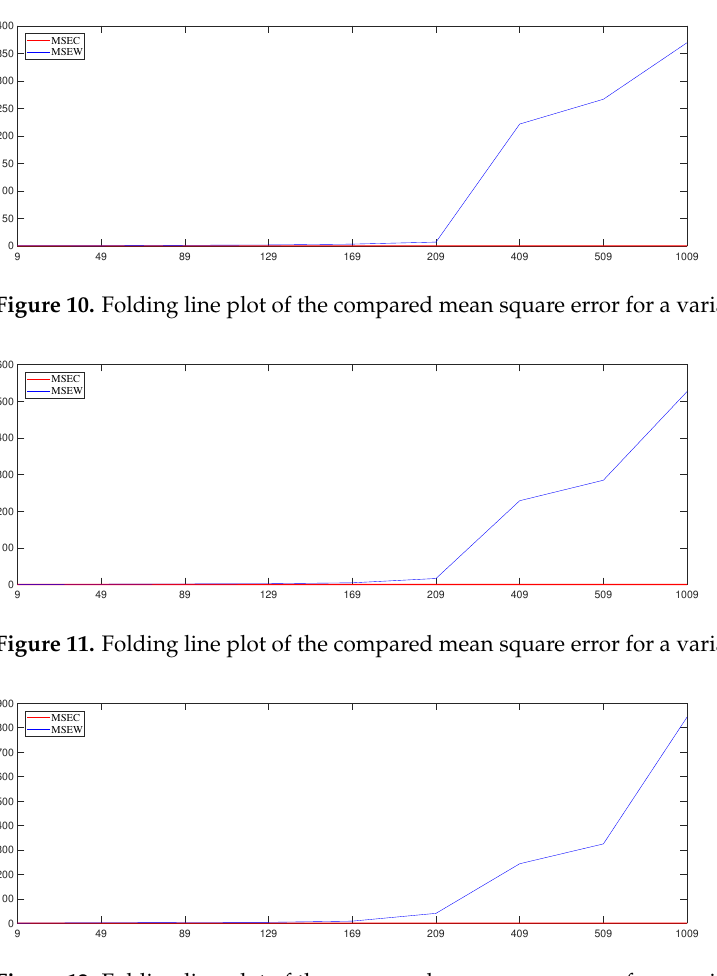
Figure 12. Folding line plot of the compared mean square error for a variance of